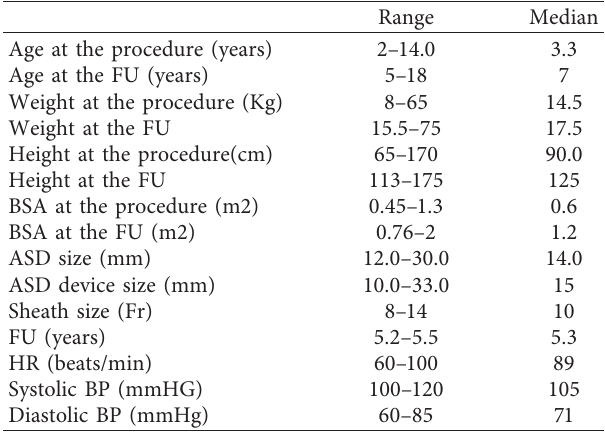
Table 1: Demographic characteristics of the study group at the procedure and last FU.